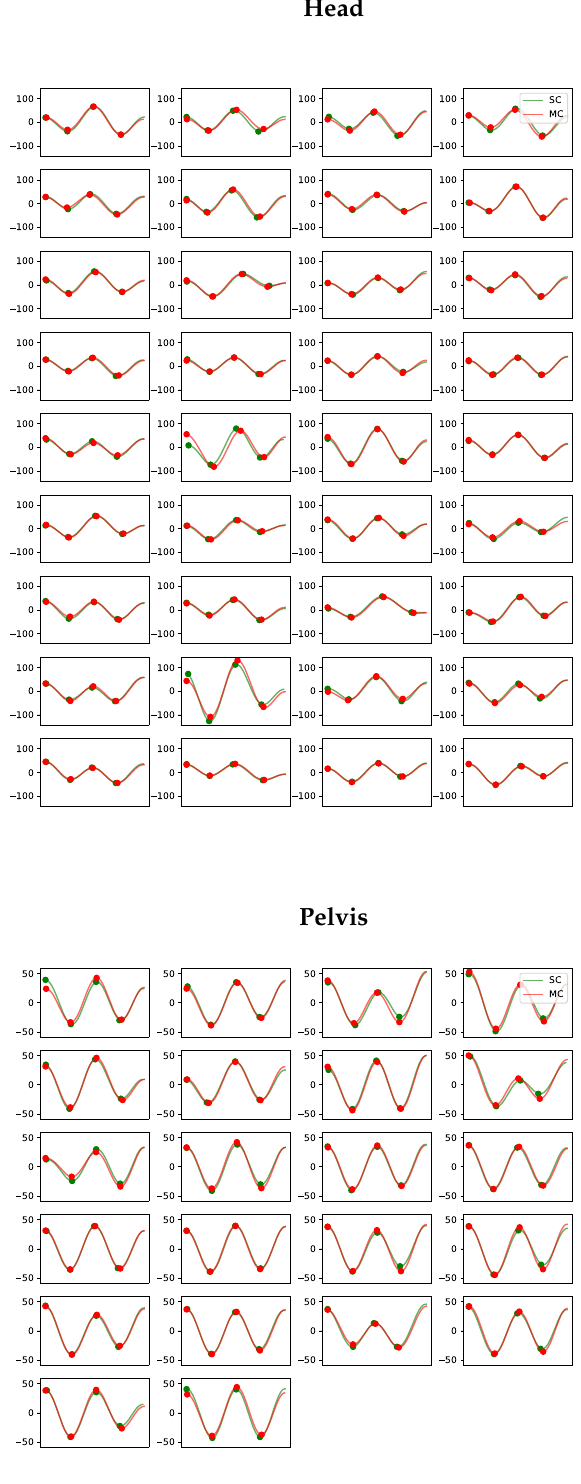
Figure A9. Vertical displacement signals per stride for the head and pelvis for horse 10. Each subplot contains the matched stride segments for the single-camera markerless system (SC) in green and the multi-camera marker-based system (MC) in red. The y-axis shows the vertical displacement in millimeters. The four dots on each curve indicate the positions of the two peaks and two valleys extracted using the approach in Section